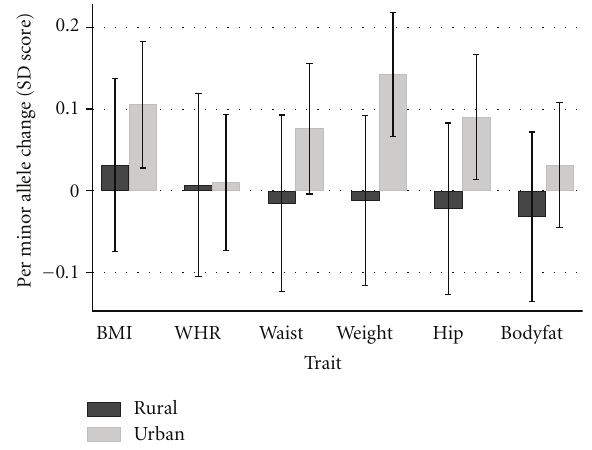
Figure 1: Associations between FTO and obesity traits by rural/ur- ban location. BMI: body mass index; WHR: waist-hip